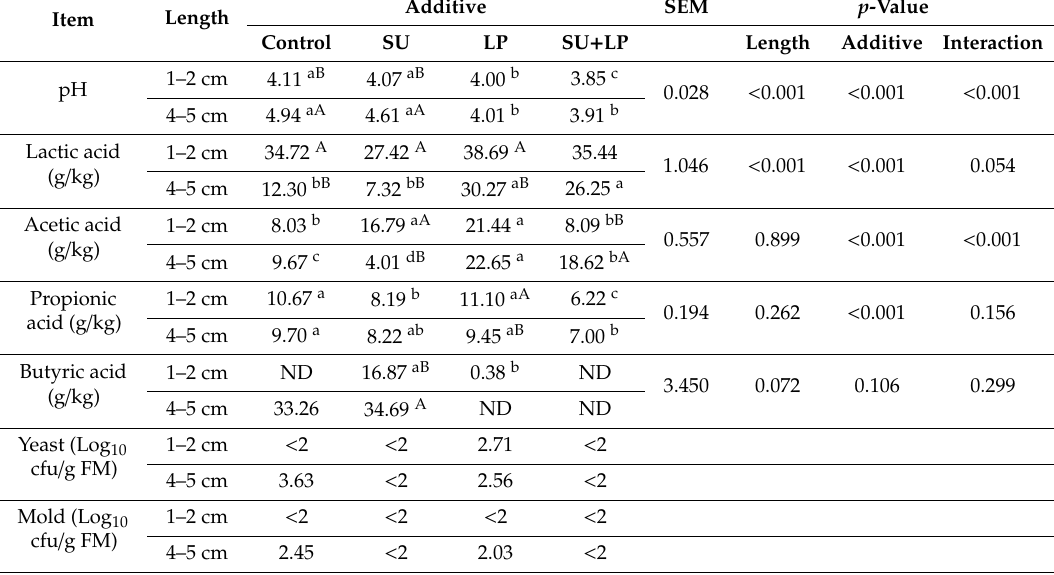
Table 3. The pH value and fermentation products of L. chinensis silage with di ff erent chopping lengths and additives after ensiling for 90 d (Dry matter